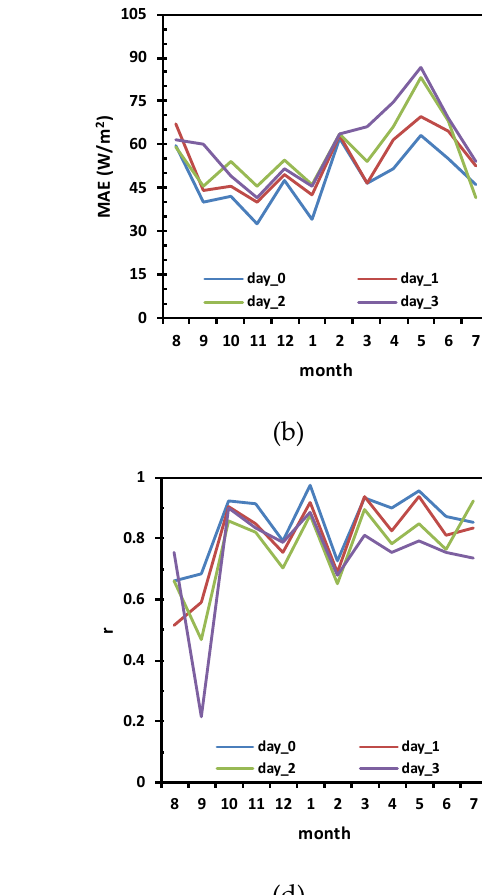
Figure 6. Monthly mean of predicted and observed daily mean DNI in Évora for the four different forecast days in the period from August 2018 to July 2019.